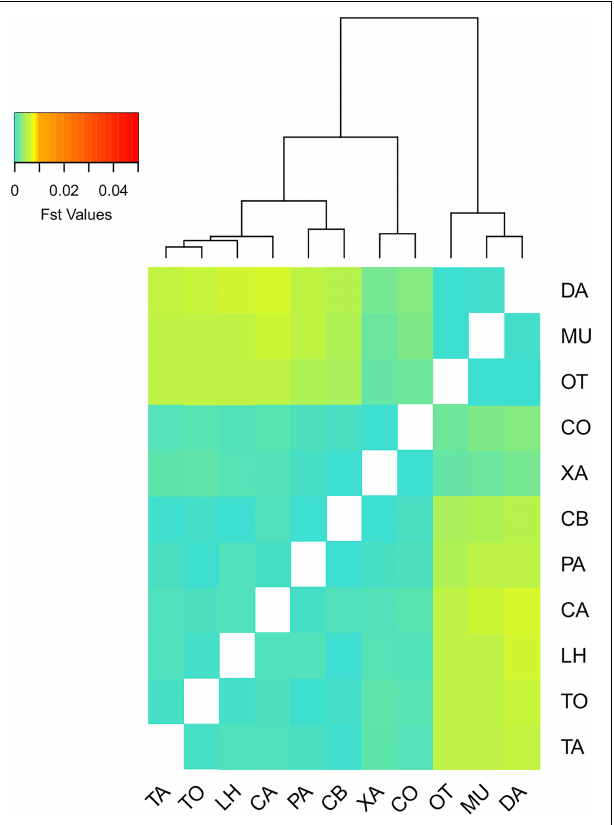
FIGURE 2 | Heatmap and cluster analysis based on the F ST values between populations. Note that the color scale is set at the same ranges as in Supplementary Figure 4 to facilitate